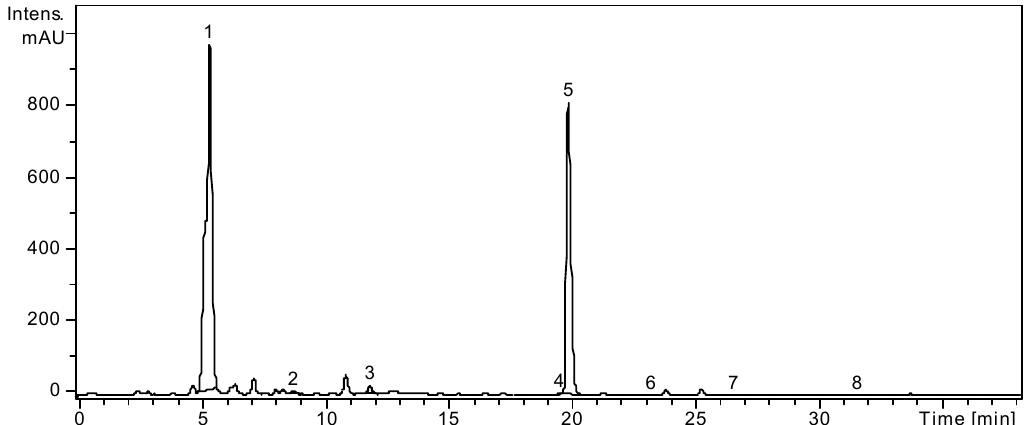
Figure 2. HPLC chromatogram of L. chinense